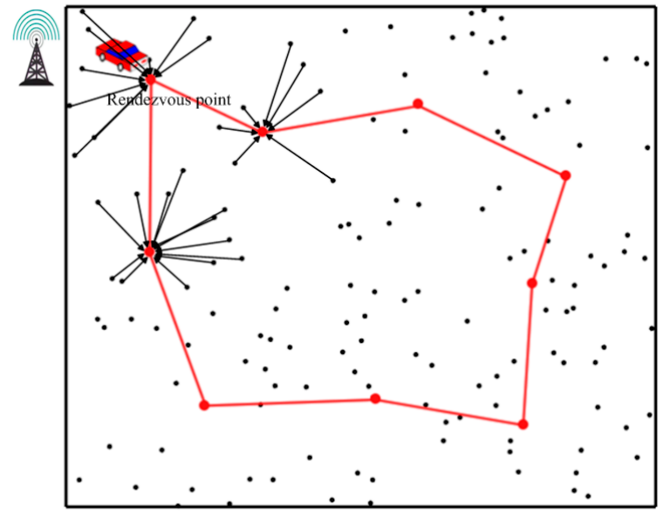
Figure 3. Rendezvous-based schema with a mobile data collector.